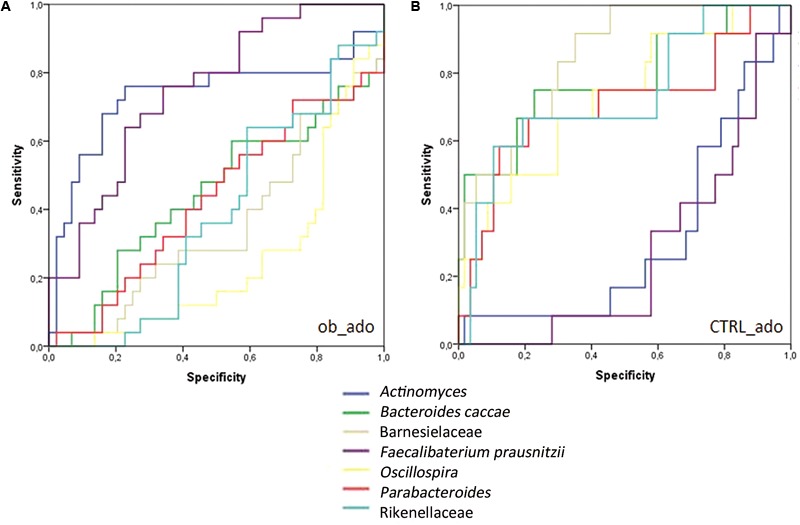
Receiver operating characteristic (ROC) curve plots. The areas under the ROC curves (AUROC) represent the specificity and sensitivity of the seven selected OTUs (AUROC > 0.7) able to discriminate ob_ado (A) and CTRL_ado (B) groups.